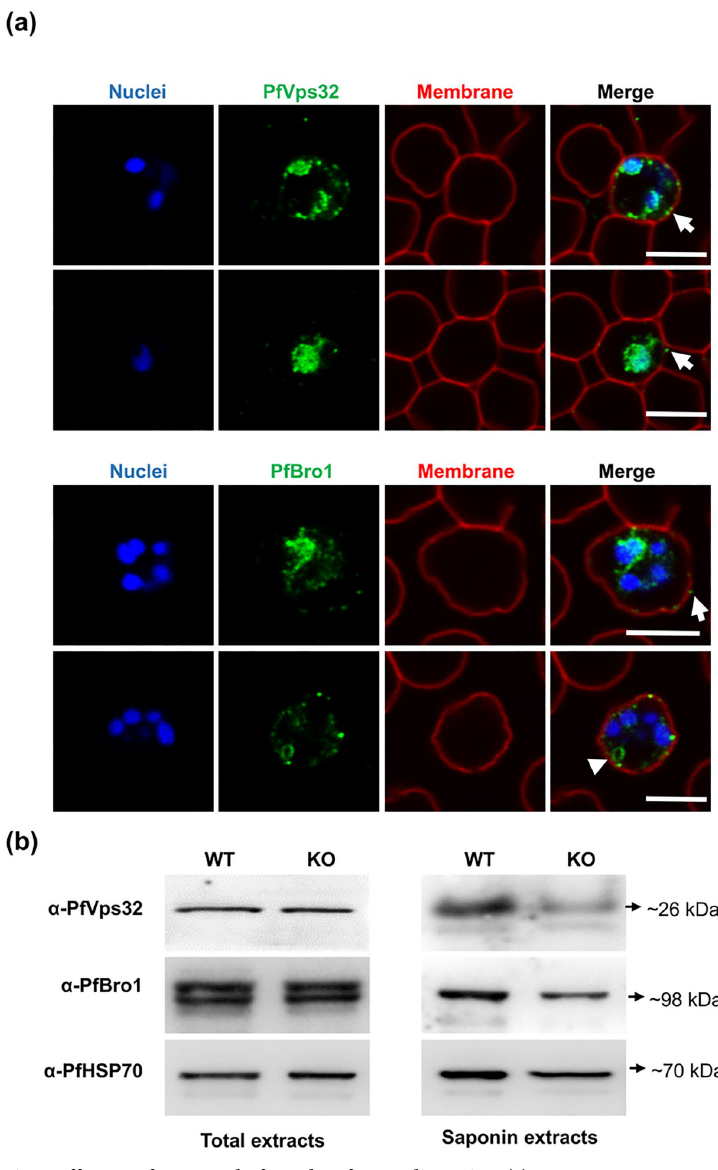
Fig 7. Effect on PfVps32 and PfBro1 by PfVps60 disruption. (a) Representative images of human erythrocytes infected with a P . falciparum KO- PfVps60 strain and fixed with 4% PFA to detect PfVps32 and PfBro1 proteins (green) and WGA (red) by indirect immunofluorescence. Cell nuclei were visualized with Hoechst 33342 (blue). Arrows show protein-labeled puncta adjacent to the membrane of the pRBCs. The arrowhead shows a vesicle-like structure labeled with PfBro1. For each protein are shown two microscope fields corresponding to the KO strain. Scale bars: 10 μ m. (b) Western blot assays using total protein extracts or the saponin fraction obtained from pRBCs infected with either the WT 3D7 or the KO- PfVps60 strain to detect proteins indicated on the left side of the panels.